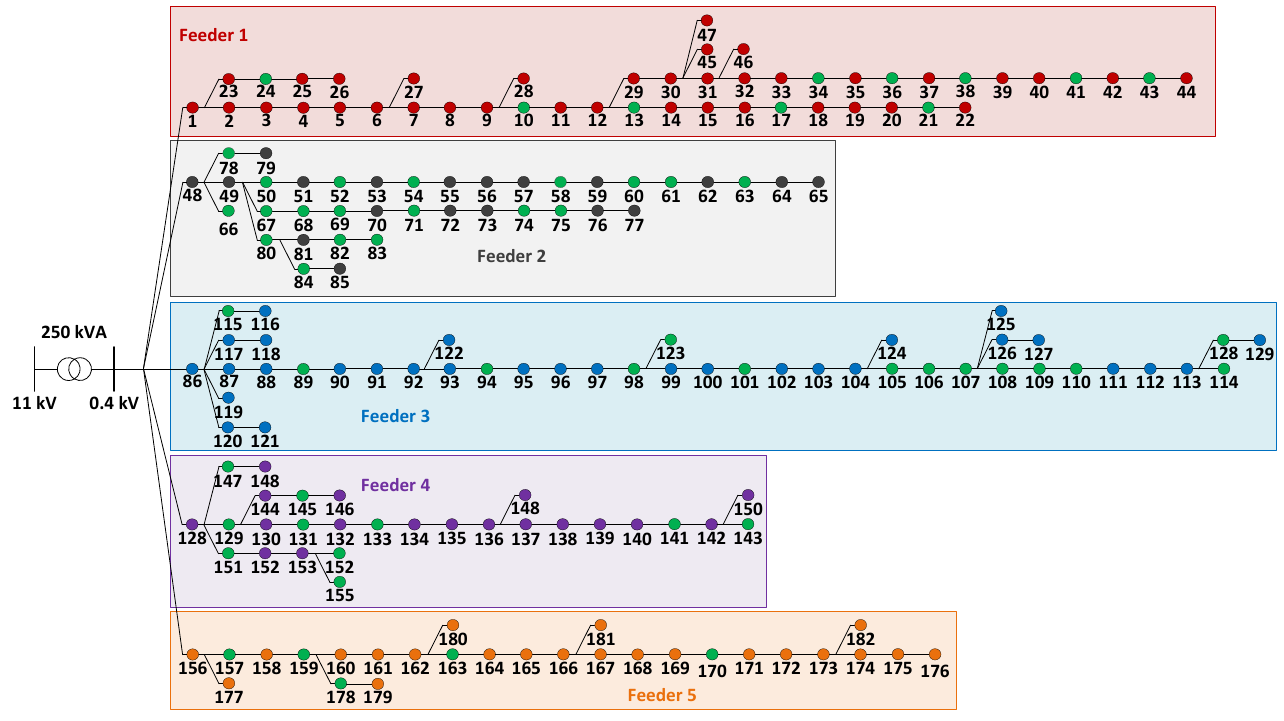
Figure 4. Simplified line diagram of the LV network at secondary substation. Feeder nodes are color coded for ease of reference (Red—Feeder 1, Black—Feeder 2, Blue—Feeder 3, Purple—Feeder 4, Orange—Feeder 5). Nodes where PV systems are connected are shown in green. Substation trans- former is showing the nominal ratio without the off-load tap changer settings. The numbers in the figure identify the individual nodes of the LV network.